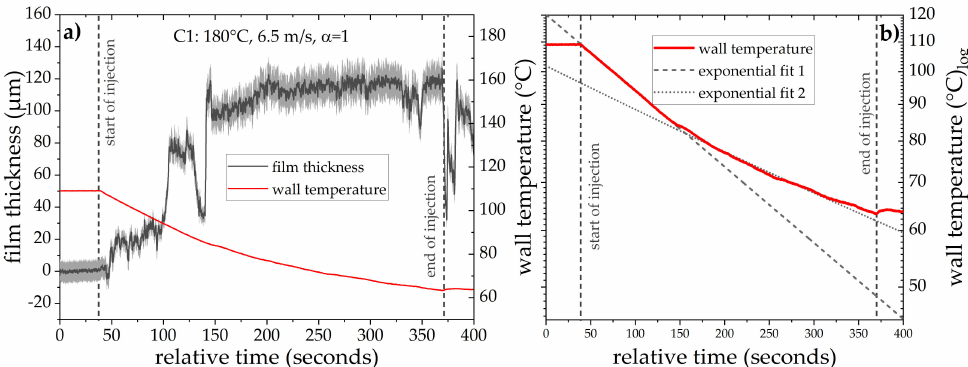
Figure 6. ( a ) Film thickness (black) of AdBlue at 180 ◦ C, 6.5 m 3 m same location 0.3 mm below the surface. The dashed vertical lines marked the beginning and end of AdBlue injection, the uncertainty is indicated in gray. ( b ) Wall temperature compared to exponential